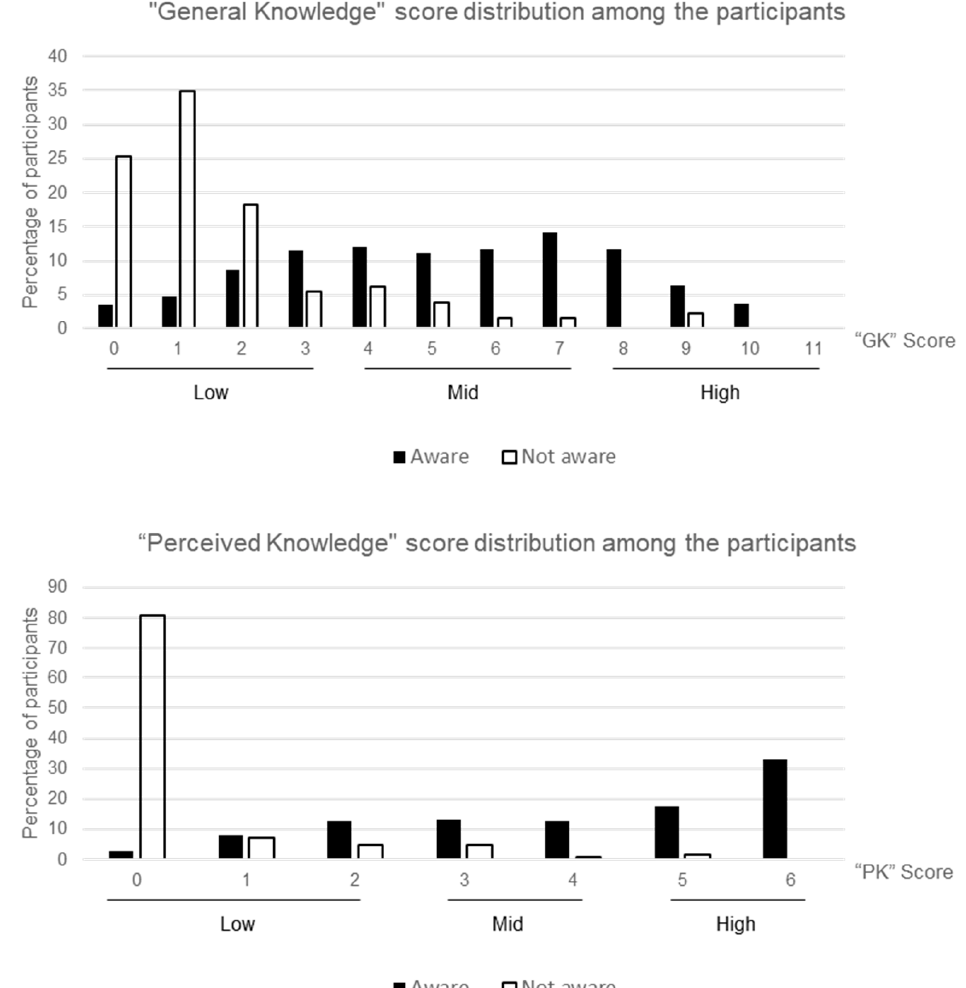
Figure 2. Level of general knowledge (“GK” score) and perceived knowledge (“PK” score) on the Wolbachia-Aedes technology among the participants.